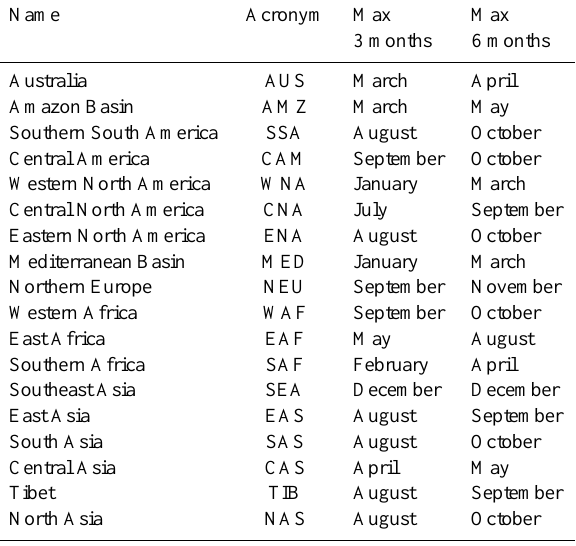
Table 1. List of regions used in this study. Adapted from Giorgi and Francisco (2000) (Fig. S1 in the Supplement and also Part 1). For each region, the calendar month with maximum accumulated precipitation in the previous 3 and 6 months (inclusive) is presented and was calculated from the mean annual cycles of